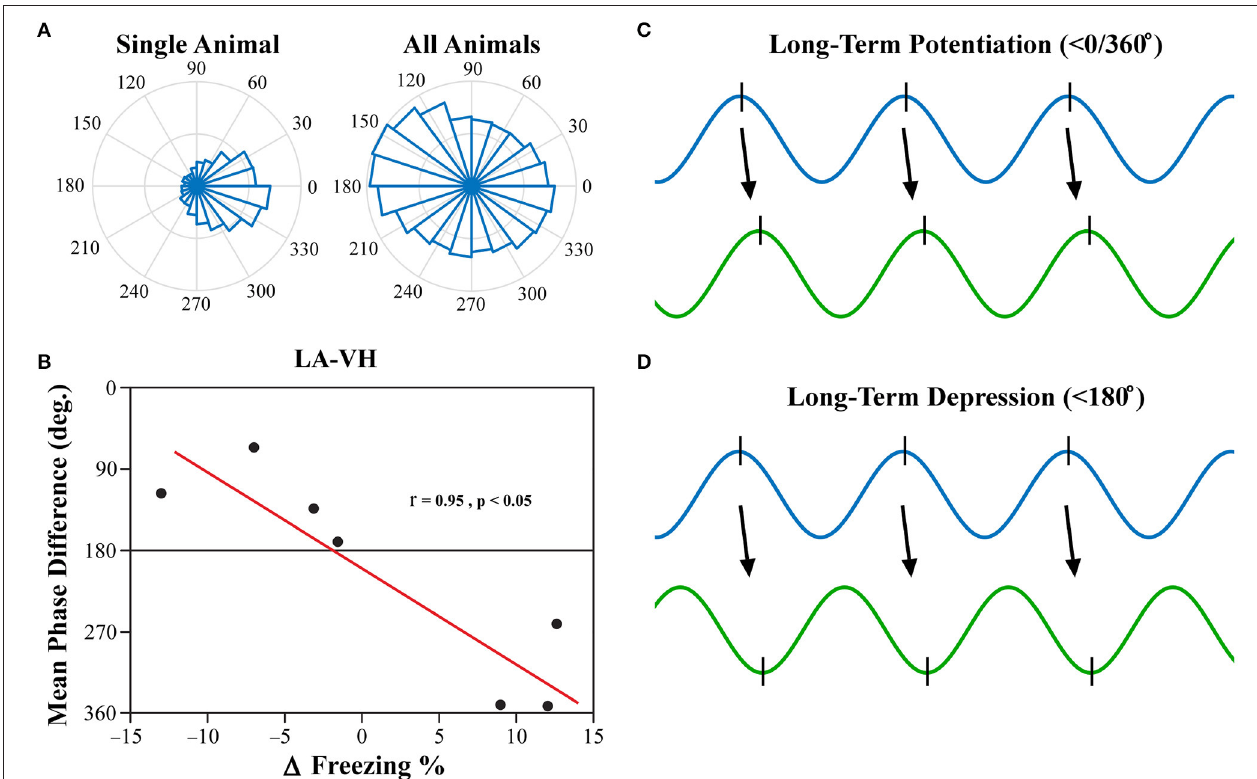
FIGURE 8 | LA-VH Mean Phase Differences of REM Sleep Theta Correlate with Changes in Freezing. Phase angle differences during synchrony were investigated to determine if there were preferred phase differences between regions. REM sleep LA-VH theta was found to display preferred phase differences within single animals, but these preferences varied across animals, as shown by the polar plots (A) . Remarkably, these between-subject variations correlated to changes in freezing from the last group of five EX trials to the subsequent group of five Testing trials (B) . Animals that showed a decrease in freezing had mean phase differences of just below 180 ◦ , whereas those that displayed increased freezing had mean phase differences just below 360/0 ◦ . It has previously been demonstrated that neuronal input in the peak of theta oscillations induces LTP (C) while input in the trough of theta oscillations induces LTD (D) ( Huerta and Lisman, 1995; Poe et al., 2000; Hyman et al., 2003). Therefore, we hypothesize that in- and out-of-phase synchronization of theta oscillations may be a mechanism by which synaptic plasticity is modulated during REM sleep, leading to the changes in freezing displayed above. LA, lateral amygdala; VH, ventral